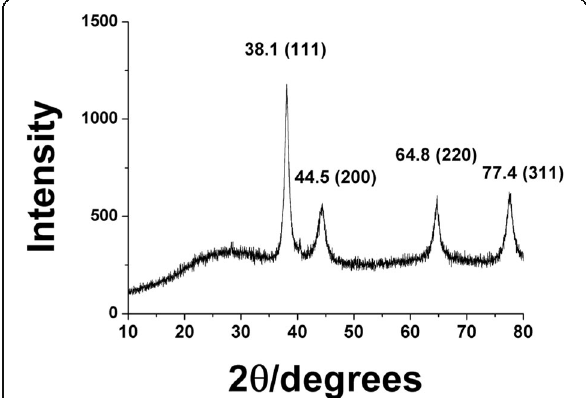
Fig. 7 HR-XRD analysis of